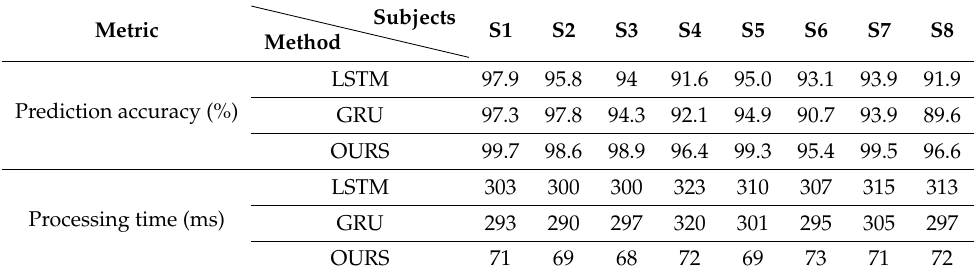
Figure 7. Prediction accuracy compared with LSTM and GRU. Table 2. Average prediction accuracy and processing time of different methods for all